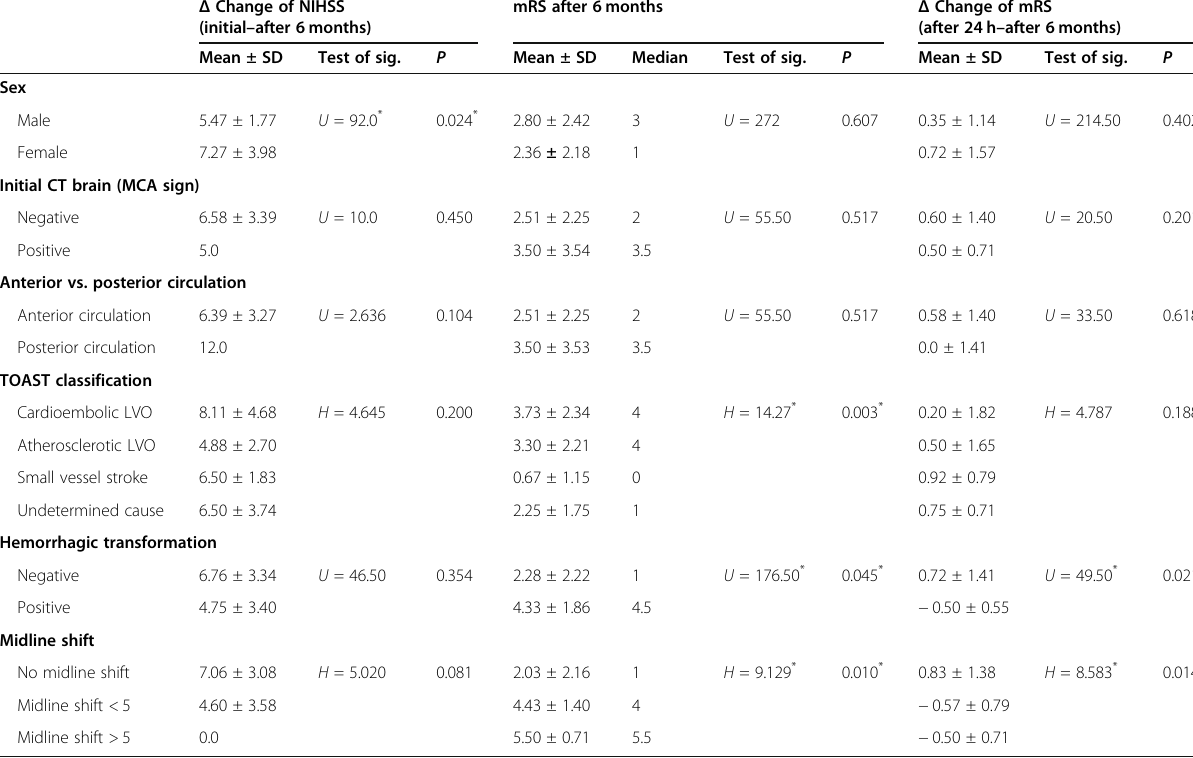
Table 5 Correlation between gender, stroke type, hemorrhagic conversion of stroke and midline shift, and the functional outcome of